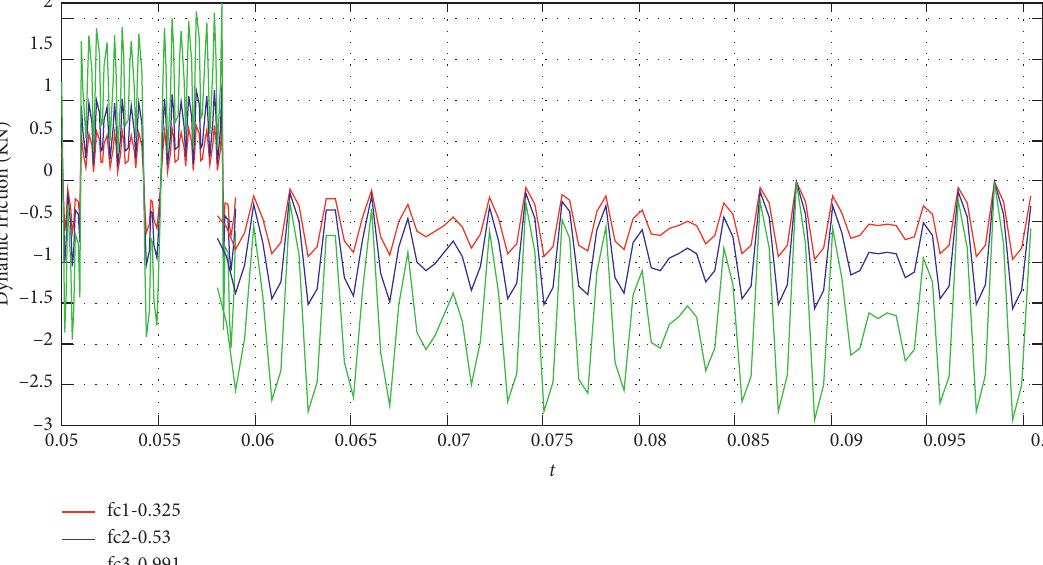
Figure 21: Dynamic friction with the Coulomb model.